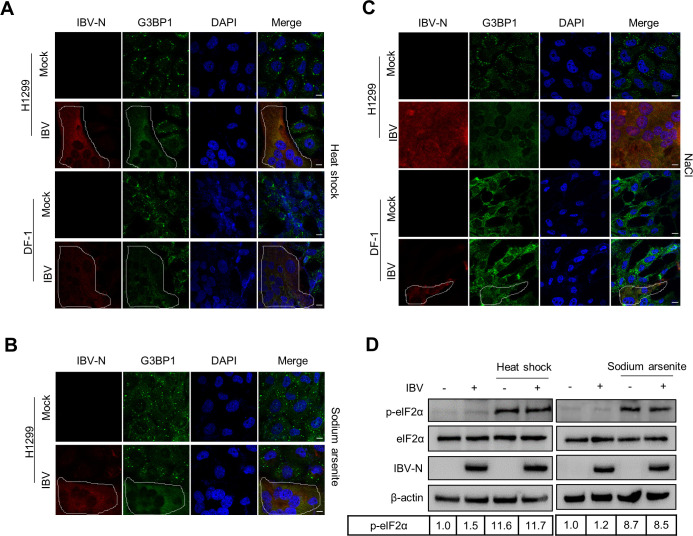
IBV abrogates eIF2α-dependent and -independent formation of SGs.(A-C) H1299 and DF-1 cells were infected with IBV an MOI of 1. At 20 h.p.i., cells received heat shock treatment (50°C for 20 min), 1 mM sodium arsenite for 30 min, or 200 mM NaCl for 50 min, followed by immunostaining. Infected cells were detected with anti-N antibody (red), SGs with anti-G3BP1 (green) and cell nuclei with DAPI (blue). The representative images of three independent experiments were shown. Scale bars: 10 μm. (D) H1299 cells were mock-infected or infected with IBV and treated with heat shock or sodium arsenite as described in A and B. At 20 h.p.i., cell lysates (10 μg per lane) were subjected to western blotting analysis to detect p-eIF2α, eIF2α, IBV-N, and β-actin. The representative data of three independent experiments were shown. The signals of protein bands were determined by Image J. The intensities of p-eIF2α were normalized to total eIF2α. The ratio of p-eIF2α in IBV-infected cells, heat shock-treated cells, or sodium arsenite-treated cells, to mock-infected cells, were shown as p-eIF2α.